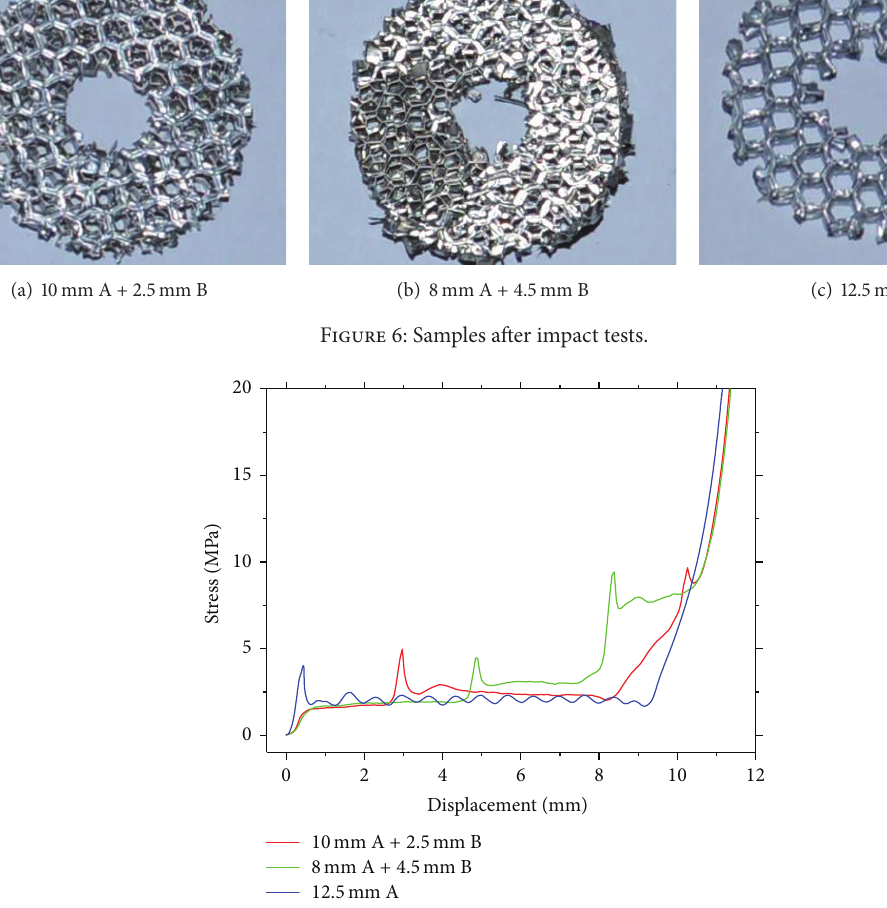
Figure 7: Compressive curves of three aluminium honeycomb